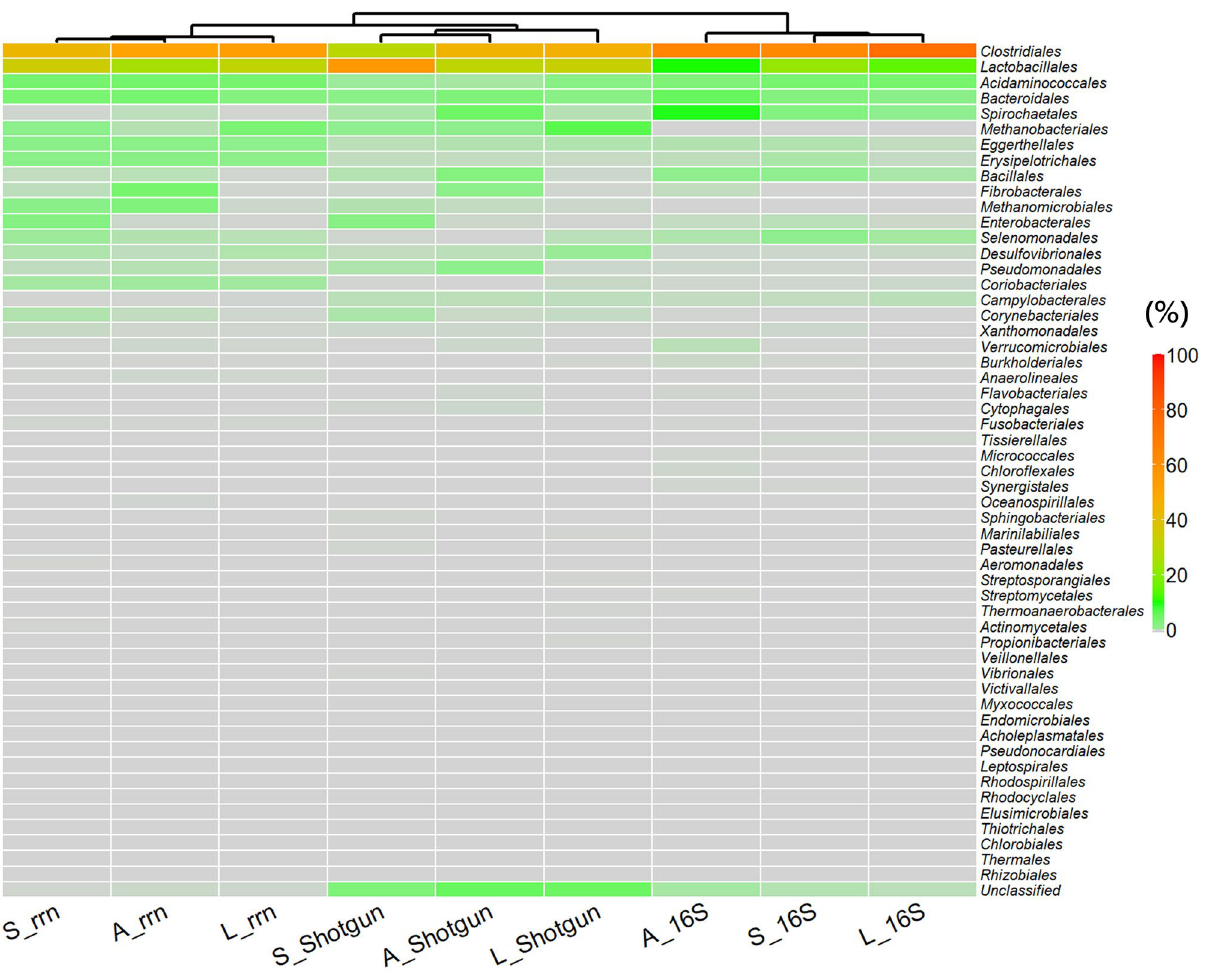
Figure 5. Heat map of each order assigned and hierarchical clustering of sample types. The hierarchical clustering shows that the samples from the amplicon sequencing with rRNA operon are grouped with those from shotgun sequencing. Sample types are shown as in Fig.